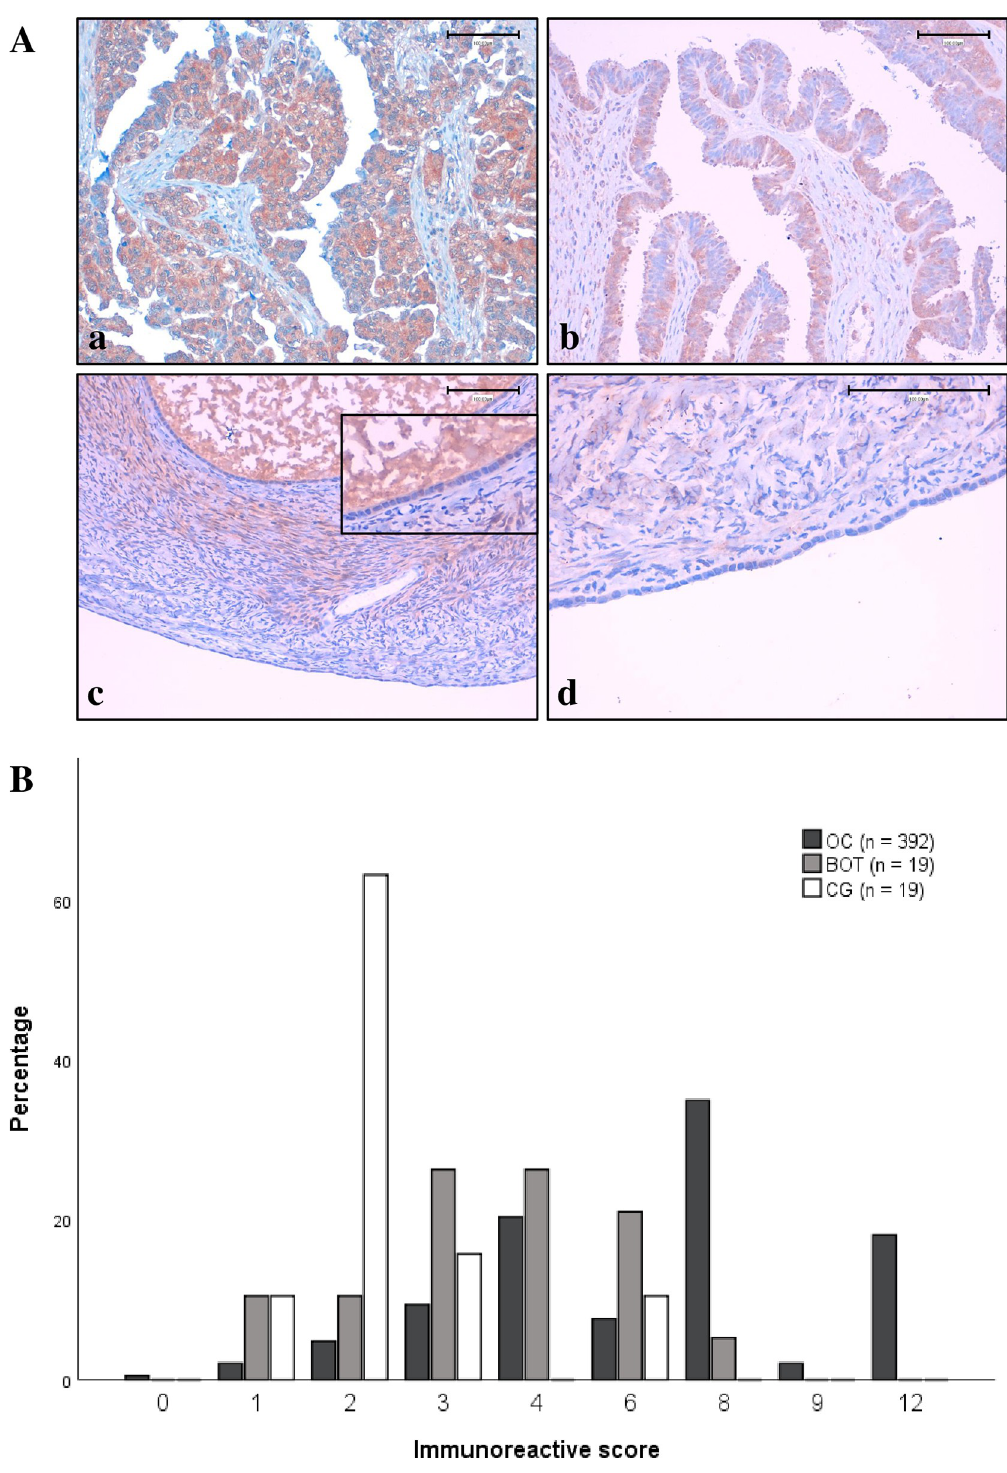
Fig 1. CA XII expression across cohorts. (A) Immunohistochemical detection of CA XII in OC (a), BOT (b), ovarian cortex with inclusion cyst (c), and surface epithelium (c, d). × 200 magnification was used for a, b, c, and × 400 magnification for d (scale bars: 100 μ m). (B) Distribution of IRS values. The y-axis indicates the percentage within each cohort.